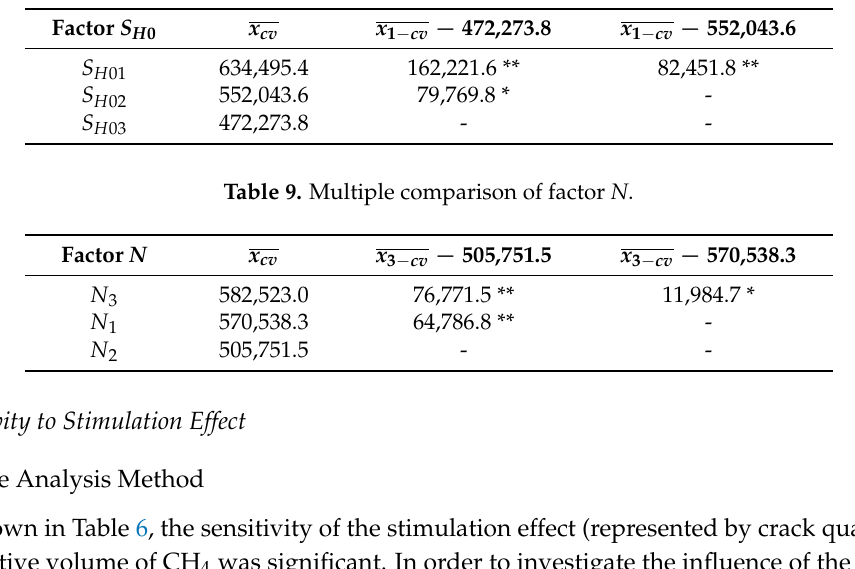
Table 8. Multiple comparison of factor S H 0 .